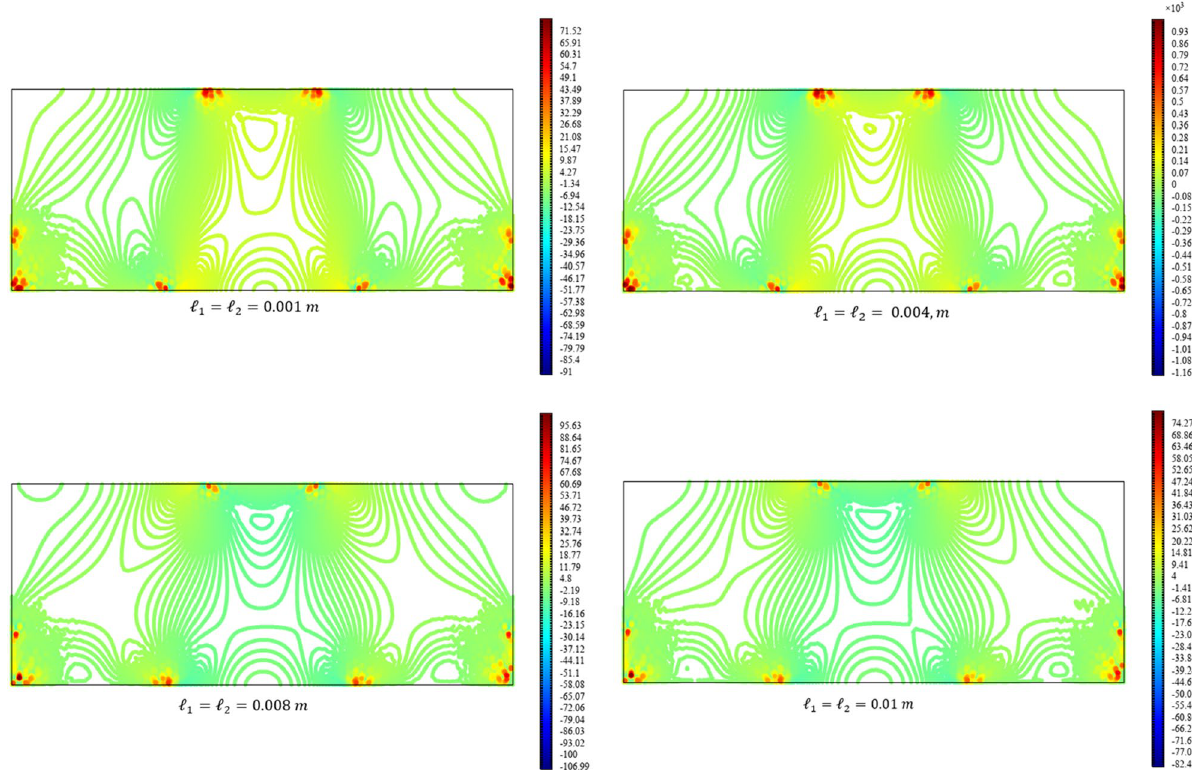
Figure 5. Contour plot for the micro-strain s xx